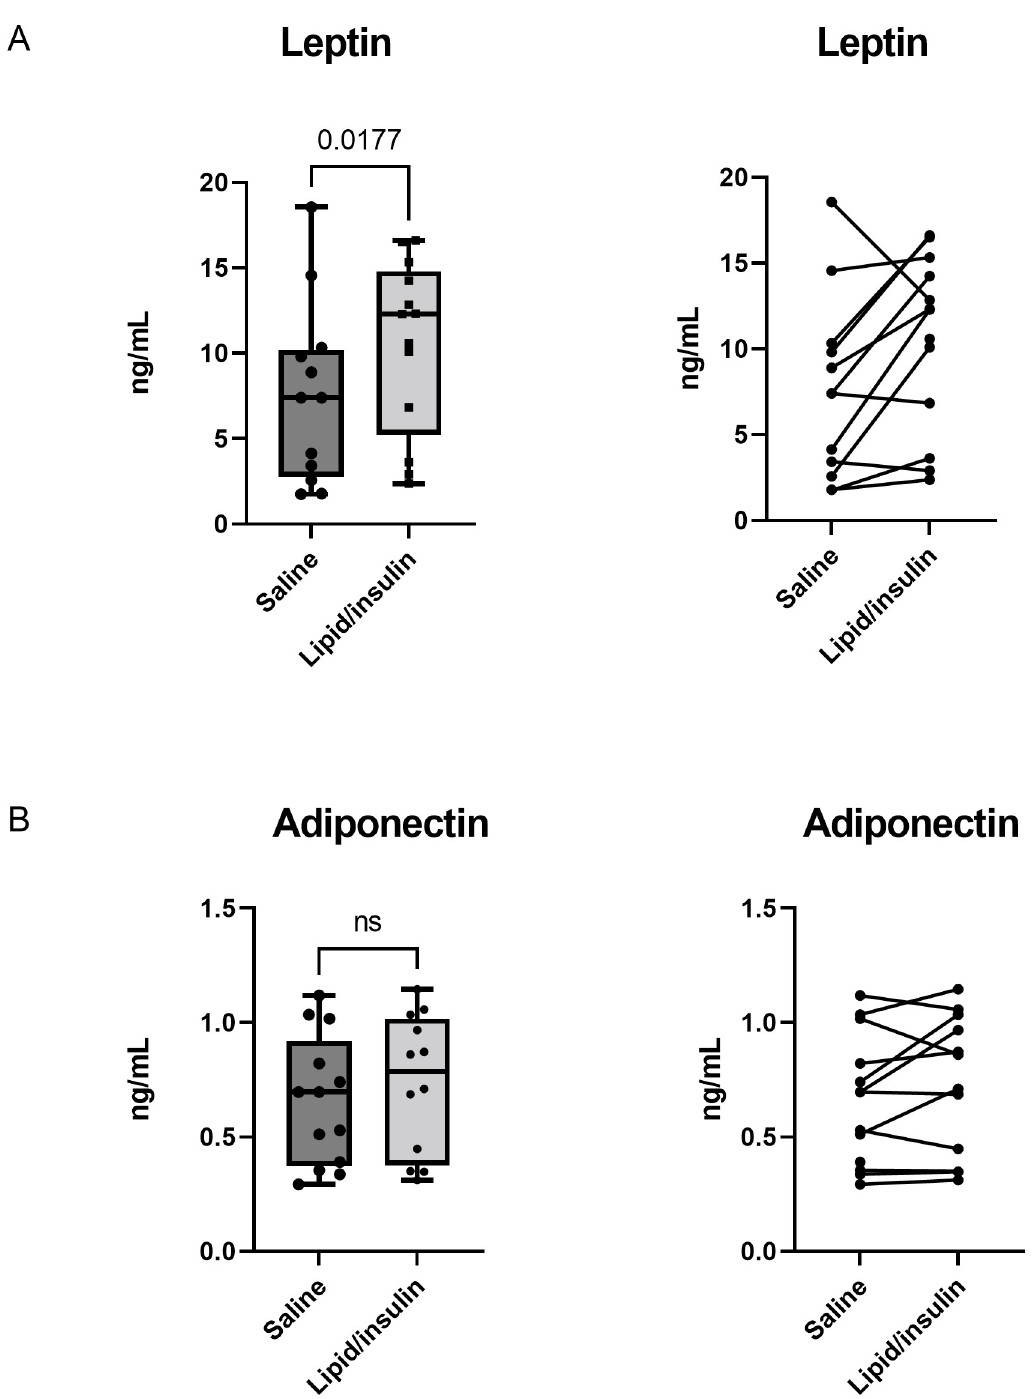
Fig 7. Lipid/insulin infusion increases leptin and has no effect on adiponectin. (A) Pooled levels of serum leptin and (B) adiponectin were measured as described in methods, during saline and lipid/insulin infusion visits; boxes encompass 25 th -75 th percentiles, whiskers are maximum and minimum values, and bar indicates median. Spaghetti plots indicate paired data points for each participant for the saline and lipid/insulin infusions. (n = 12).